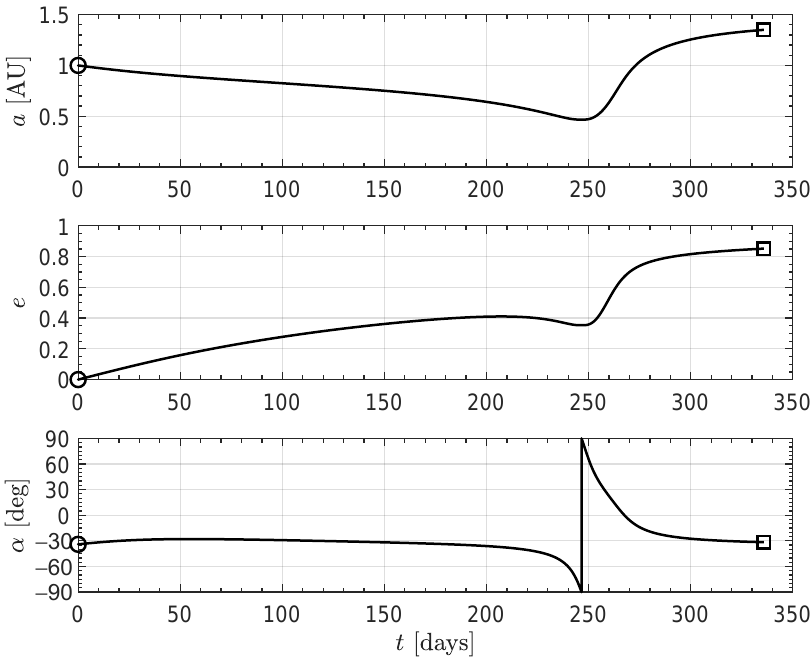
Figure 7. Osculating parameters of the transfer orbit and optimal (sail) steering law (case